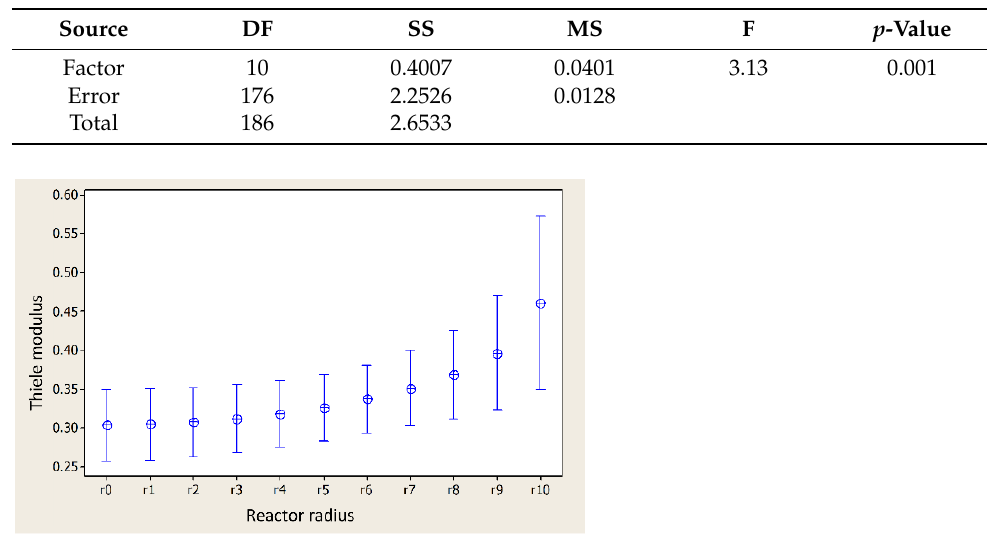
Table 3. Analysis of variance of the effectiveness factor versus the length reactor.